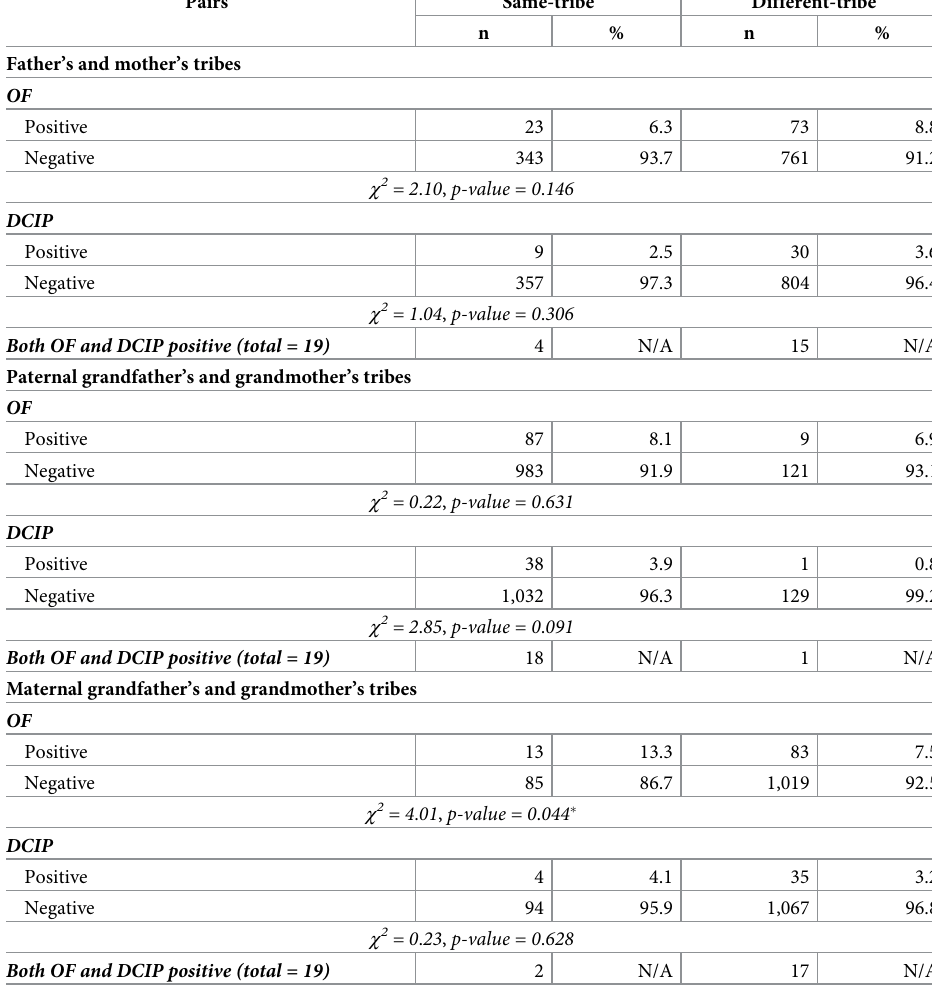
� Significance level at α =